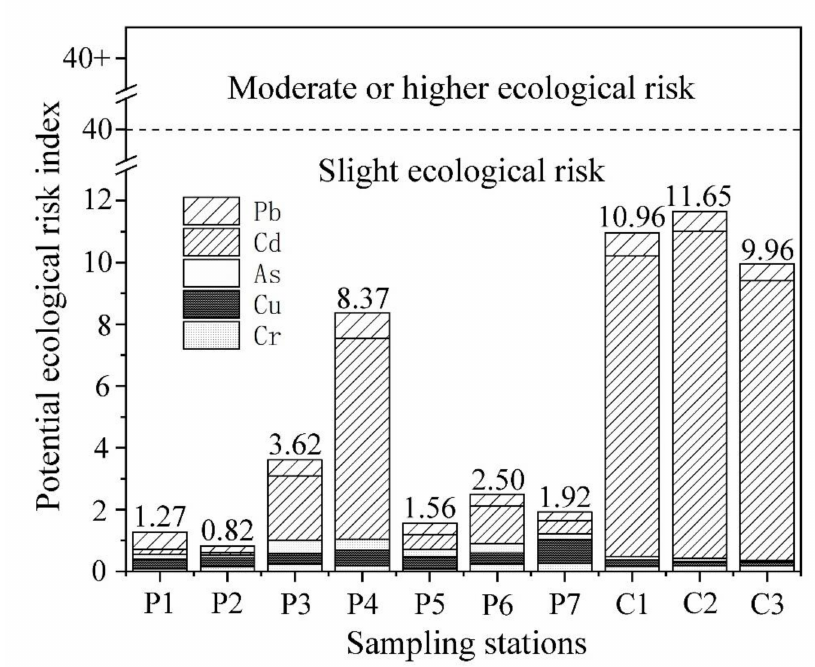
Figure 5. The potential ecological risk for five metals in